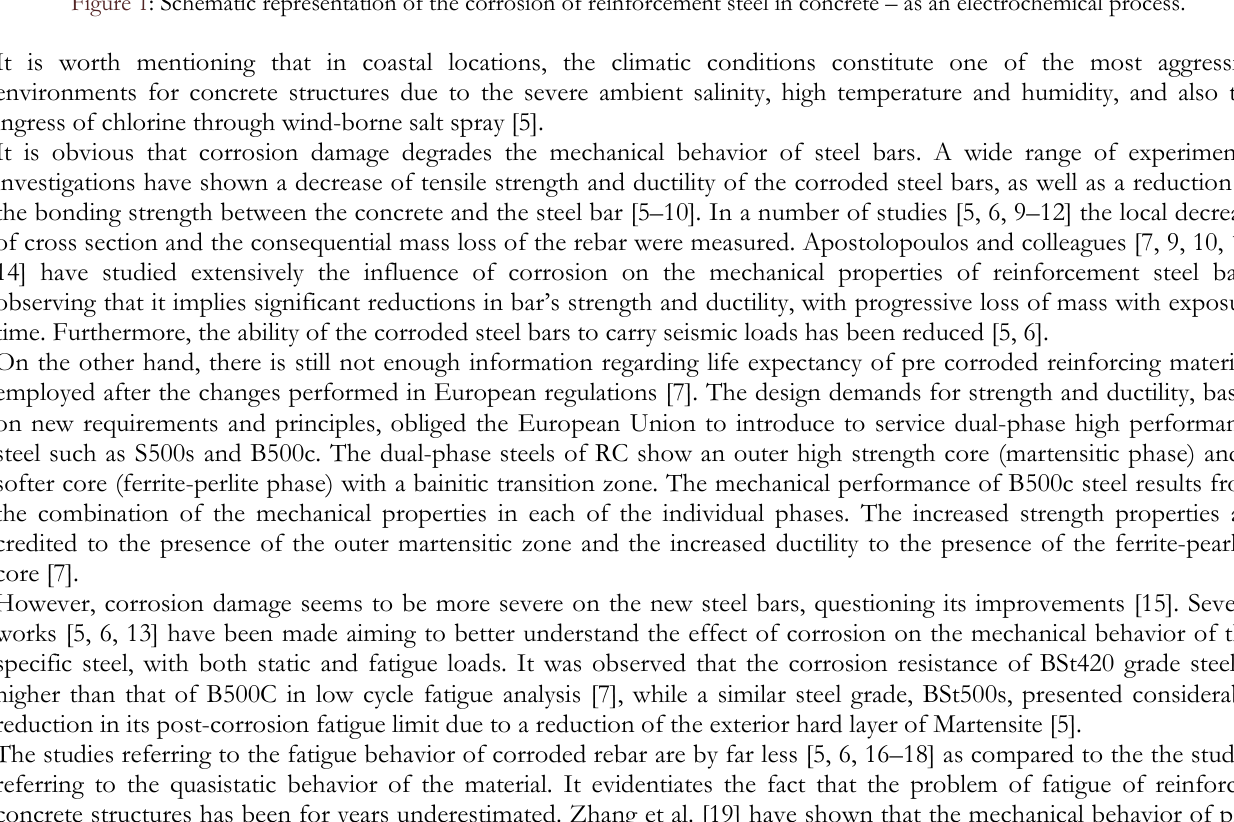
Figure 1: Schematic representation of the corrosion of reinforcement steel in concrete – as an electrochemical